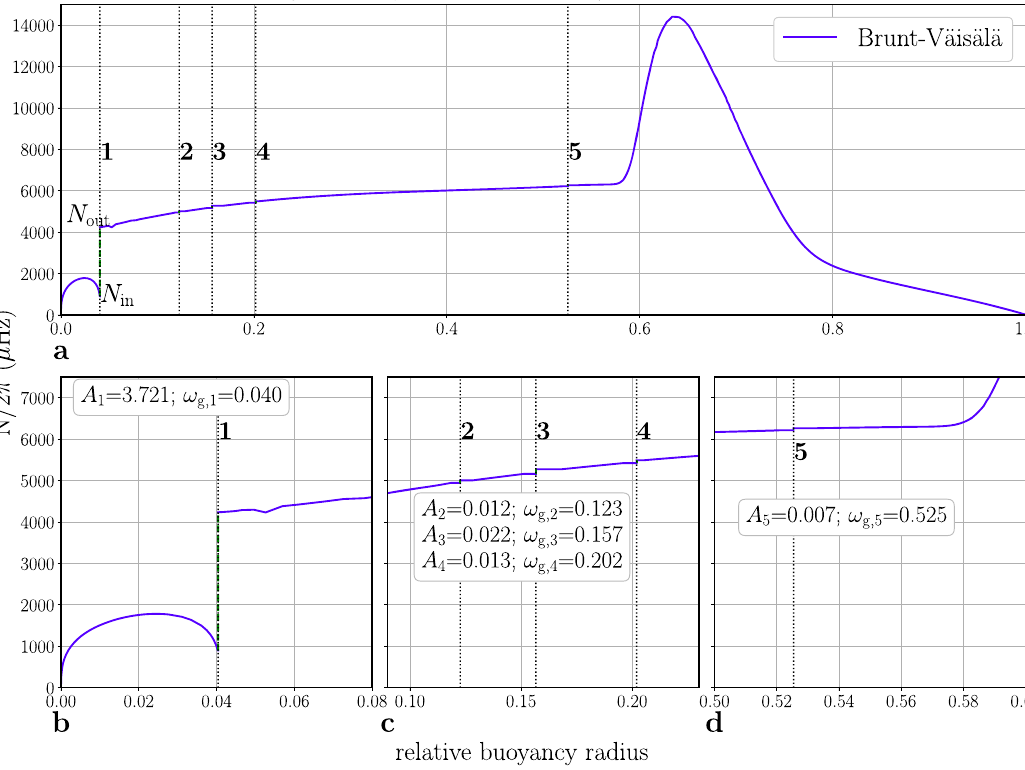
bymatterpenetrationintheradiativecavityandthedashedgreenlinedisplaysthe jumpintheBrunt-Vaisäläfrequencyatthediscontinuityposition.Theblackdotted lines labeled 2 to 5 (in a , c , d ) correspond to the glitch position caused by the different helium sub fl ashes. Source data are provided as a Source Data fi